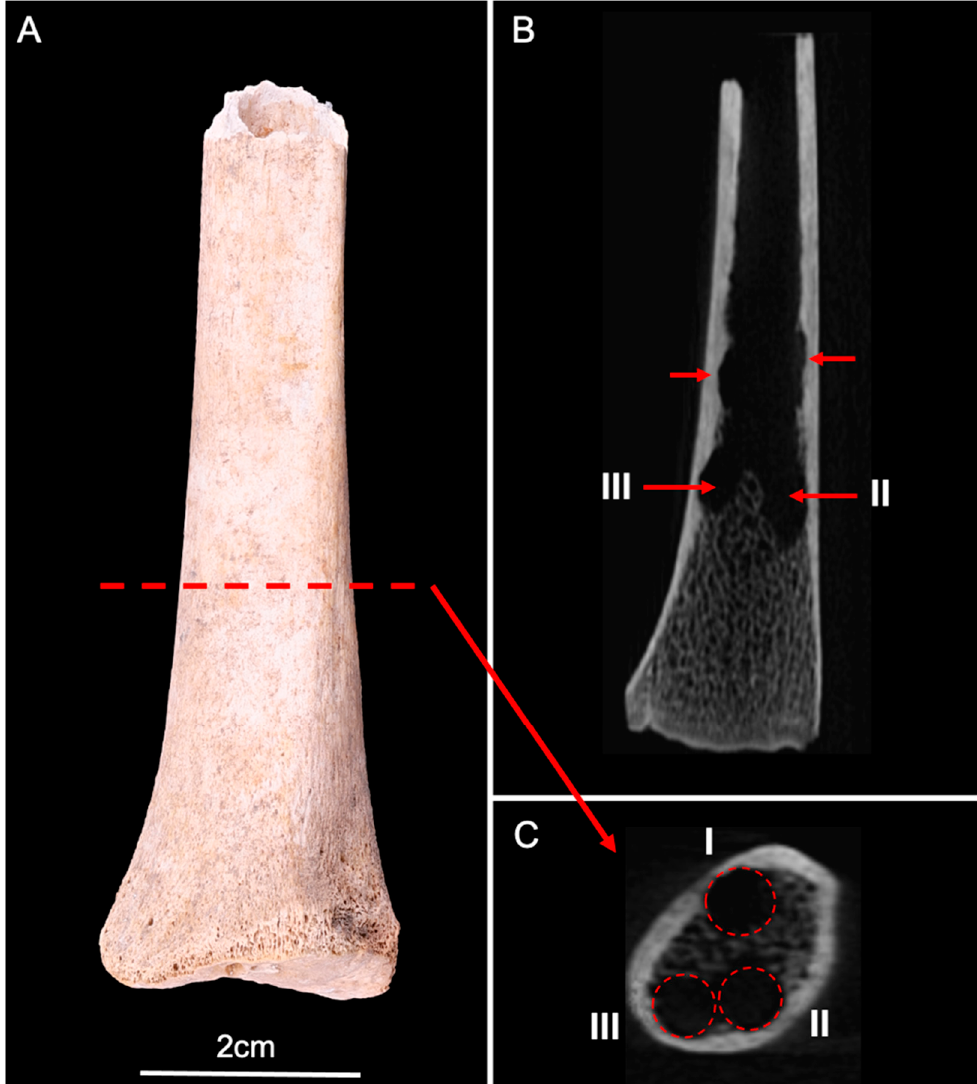
Figure 6. ( A ) Anterior view of the human radius (distal fragment). ( B ) CBCT longitudinal section showed several lesions of the inner surface of the cortical bone, and trabecular destructions (red arrows). ( C ) CBCT cross-section showed three circular lesions (I, II, and III) corresponding to pupation chambers in the distal epiphysis (red circles).